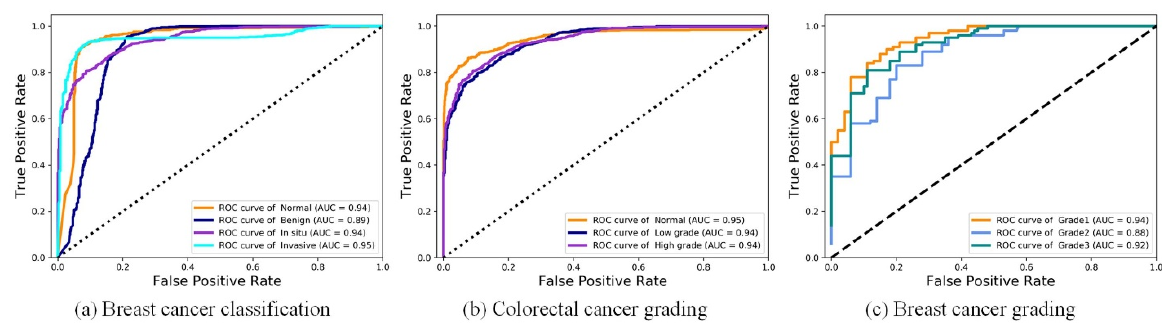
Figure 5. Visualization of normalized confusion matrix on three datasets.